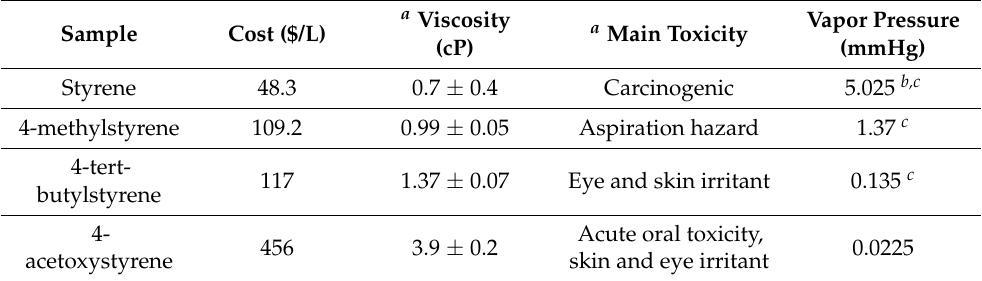
Table 2. Cost, viscosity, vapor pressure, and toxicity data of styrene and its derivatives.